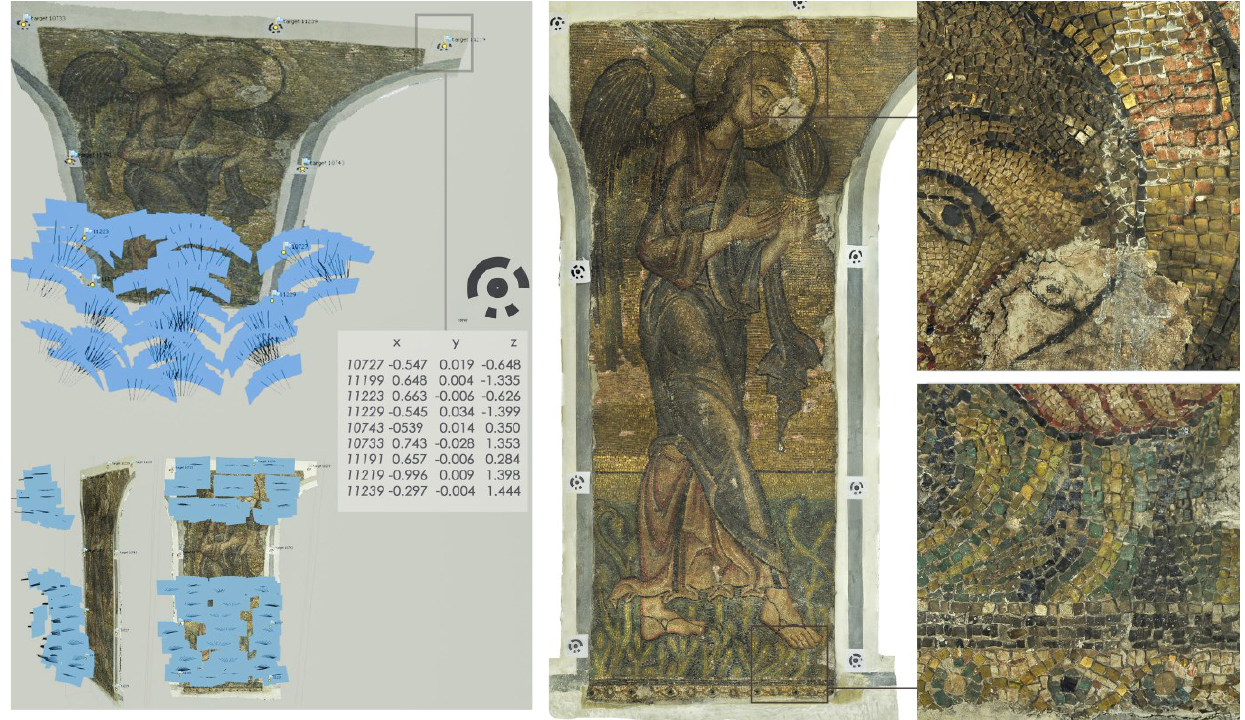
Figure 11. SfM general model and details of the Angel mosaic